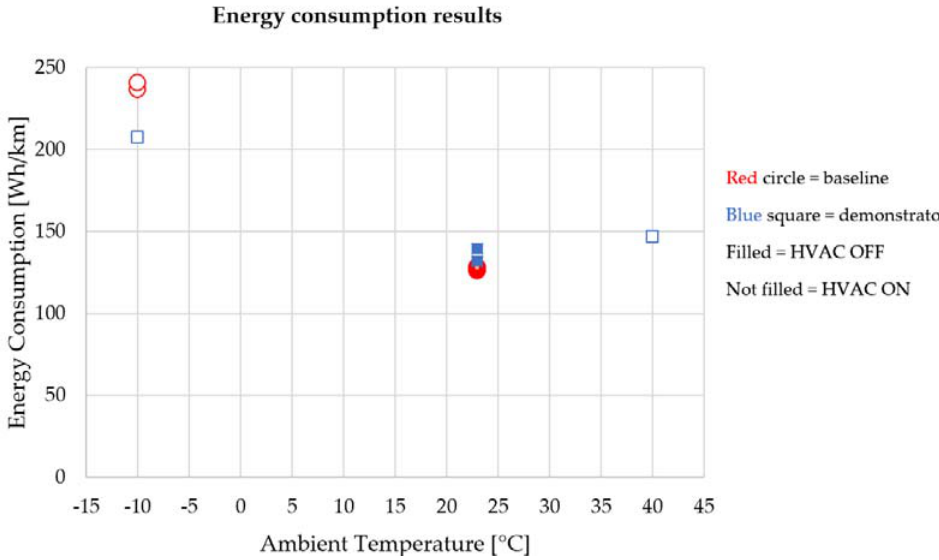
Figure 9. Energy consumption results of the baseline and demonstrator vehicle at different ambient